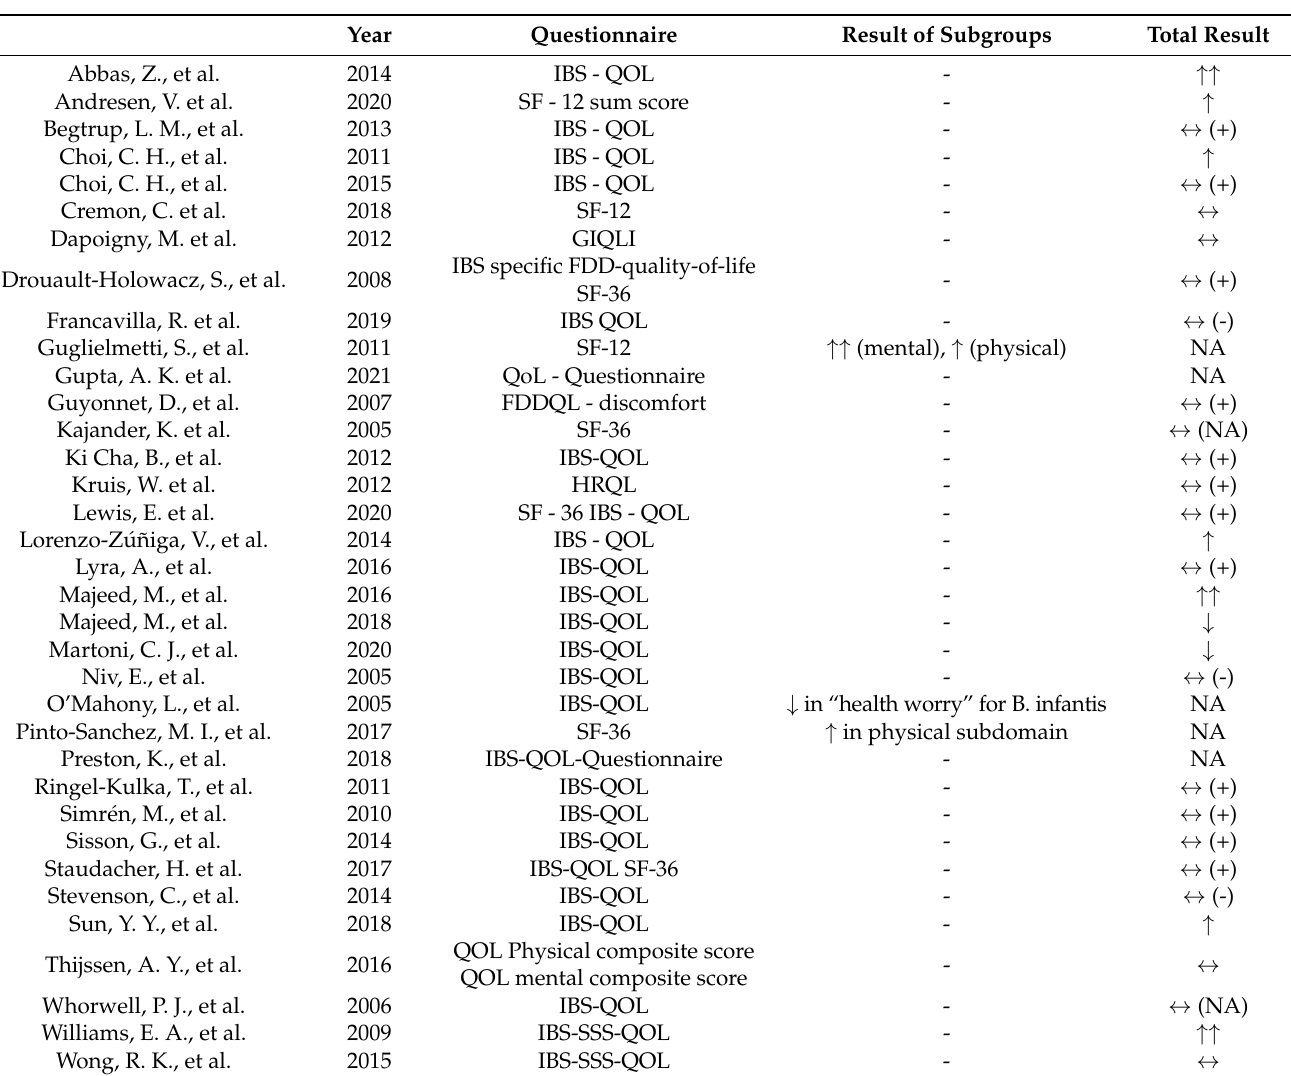
In the subgroup analysis of single-strain versus multi-strain studies in Figure 4, no significant subgroup effects were found ( p = 0.37). Thus, the number of strains had no influence on the outcome of QoL. However, heterogeneity decreased slightly when analyzing only single-strain probiotic studies (I 2 = 72%) but remained similarly high for multi-strain probiotic studies (I 2 = 91%). Table 2. QoL changes compared between probiotic versus placebo intervention. IBS: irritable bowel syndrome; QoL: quality of life; ↑↑ : QoL improvement in probiotic versus placebo group: ↑↑ = p < 0.01, ↑ = p < 0.05; QoL deterioration in probiotic versus placebo group: ↓ = p < 0.05; ↔ : no group differences and no trend in QoL; ↔ (+): no significant group differences (trend towards QoL improvement); ↔ ( − ): no significant differences between groups (trend QoL towards deterioration); NA: not